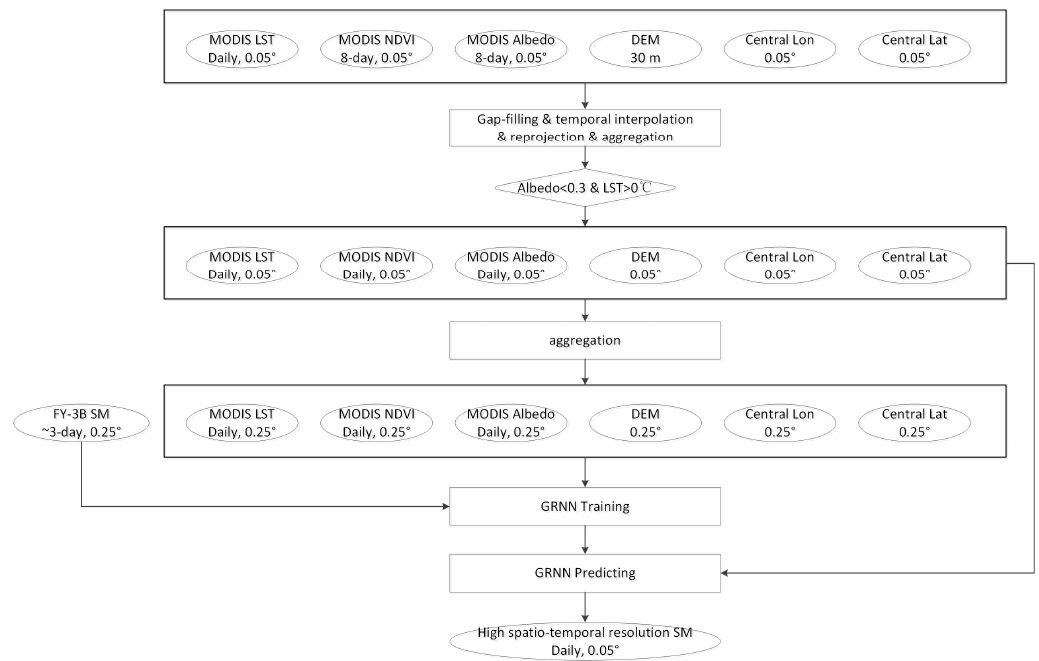
Figure 2. Flowchart of the soil moisture spatio-temporal resolution improving algorithm based on the General Regression Neural Network (GRNN) model using the FY-3B product.